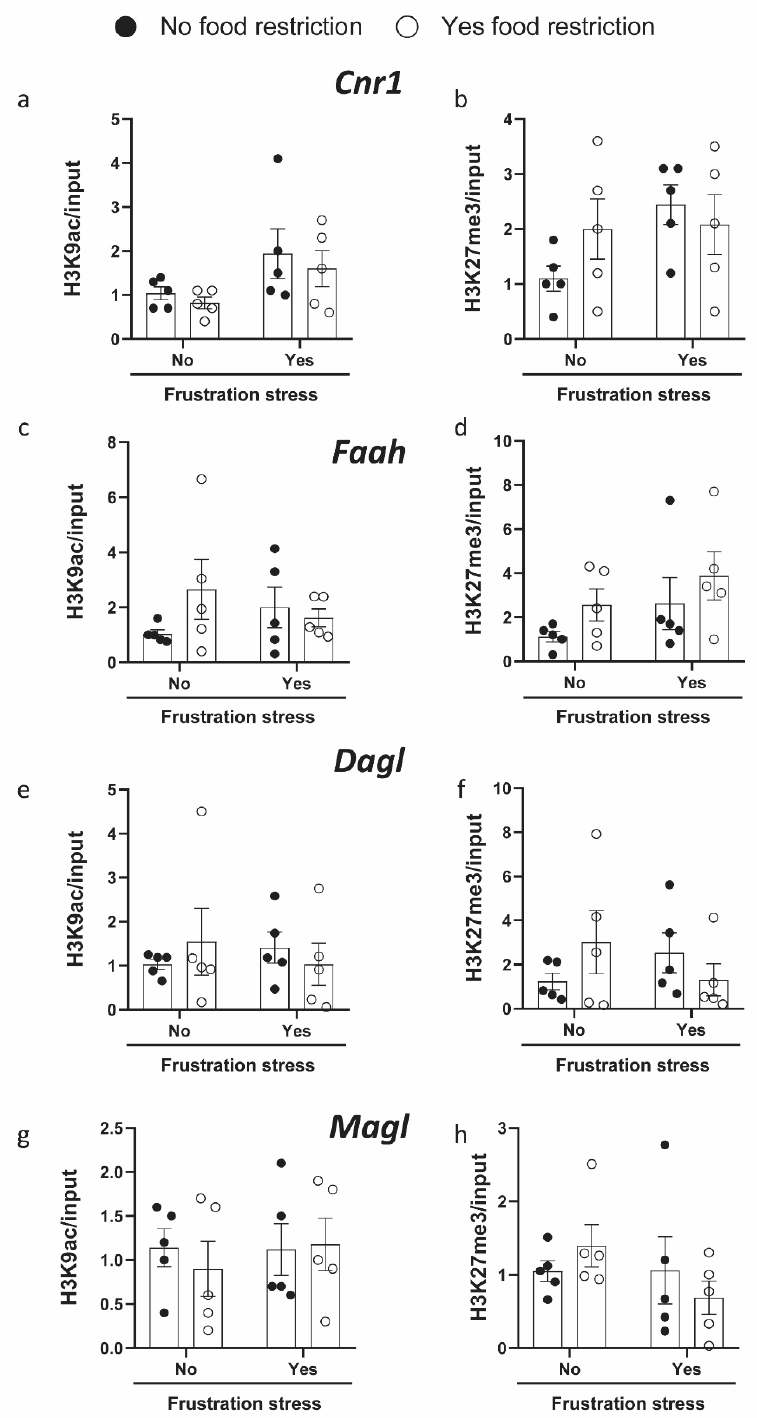
Figure 4. Cnr1 ( a , b ), Faah ( c , d ), Dagl ( e , f ) and Magl ( g , h ) promoter histone modifications. RT- qPCR analyses of H3K9ac ( a , c , e , g ) and H3K27me3 ( b , d , f , h ) immunoprecipitated DNA fragments at promoter in rat hypothalamus. ChIP histogram shows the levels of specific histone modifications, normalized to total input DNA, in rats exposed (or not) to restriction and stress. Data were expressed as means ± SEM, n = 5 per group. Data were analyzed by two-way ANOVA in a 2 (food restriction: no, yes) × 2 (frustration stress during testing: no, yes) factorial design. Bonferroni’s post hoc tests were used to follow up on significant interactions or main effects from the factorial